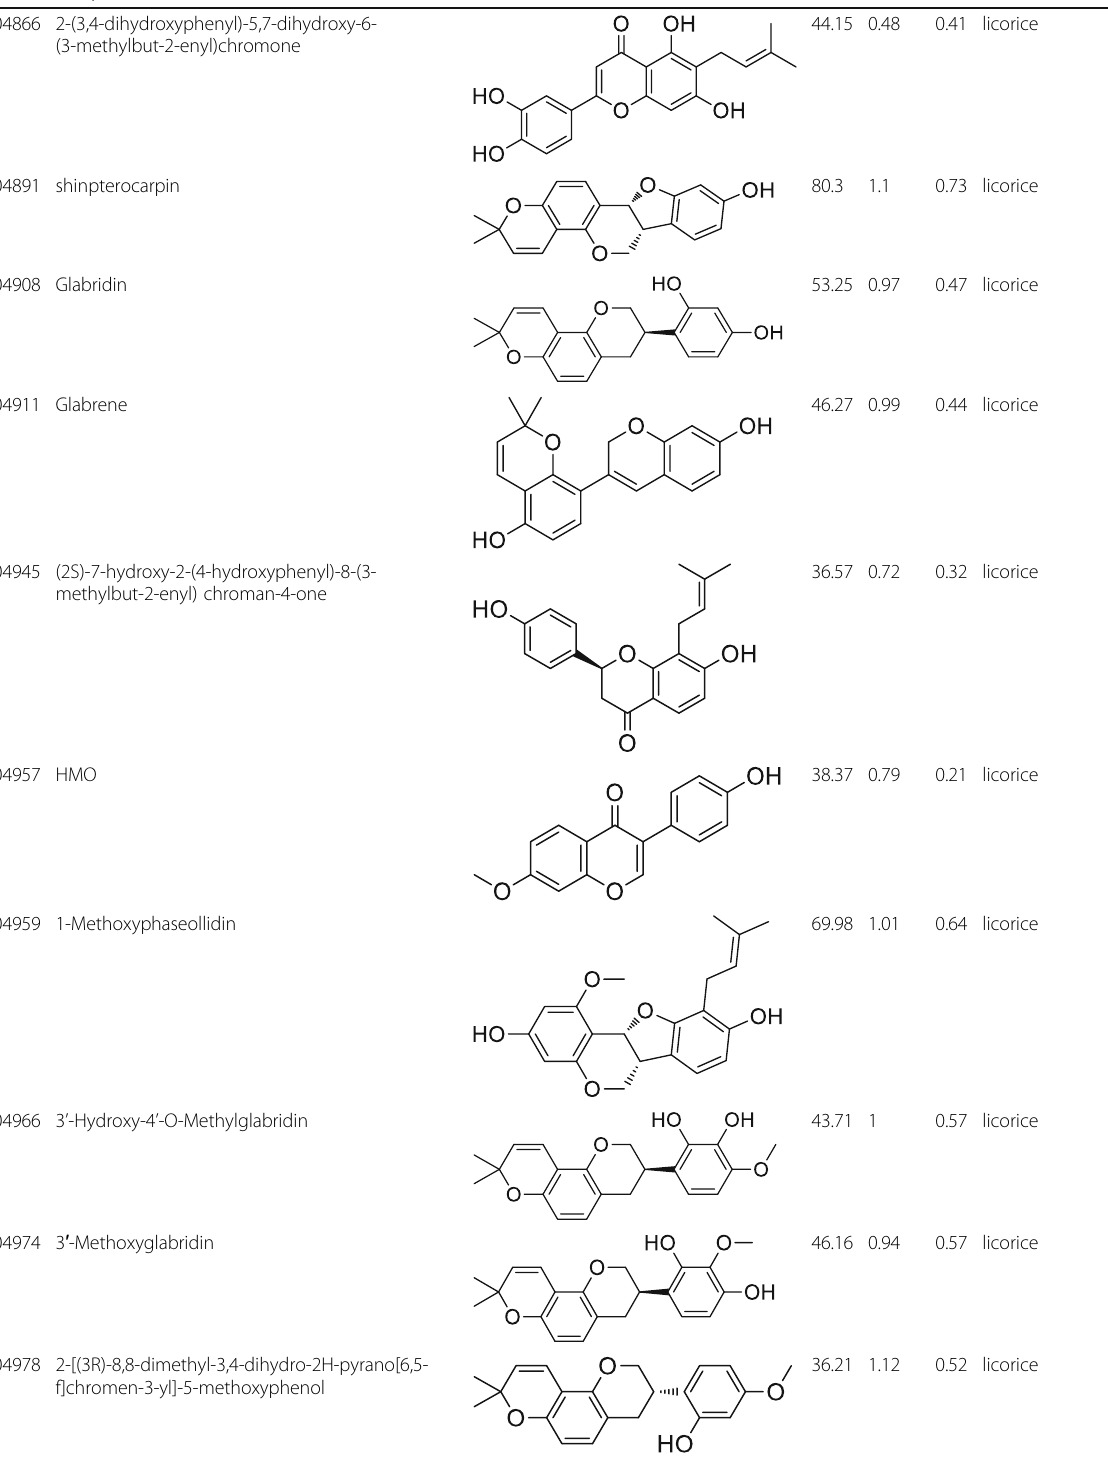
Table 1 Information of active compound by ADME filtering